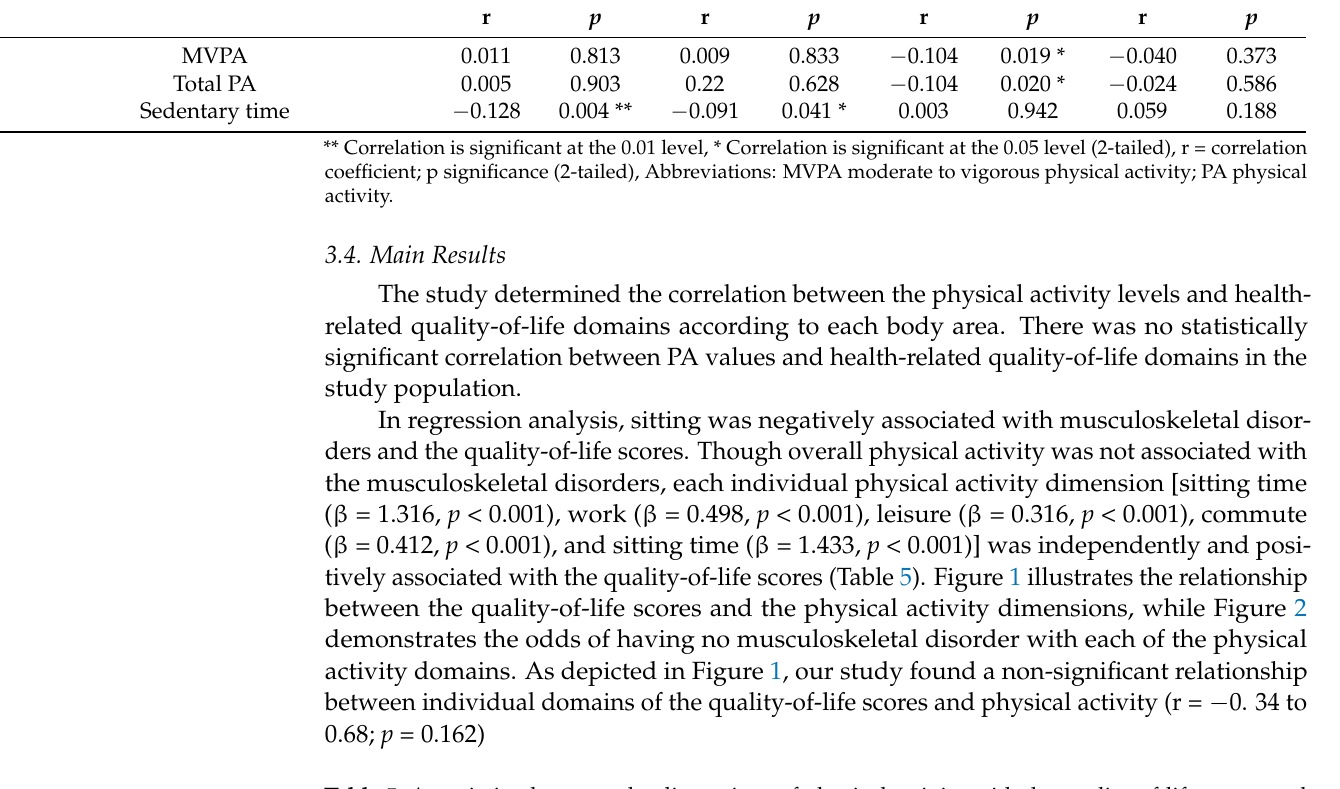
Table 5. Association between the dimensions of physical activity with the quality-of-life scores and work-related musculoskeletal